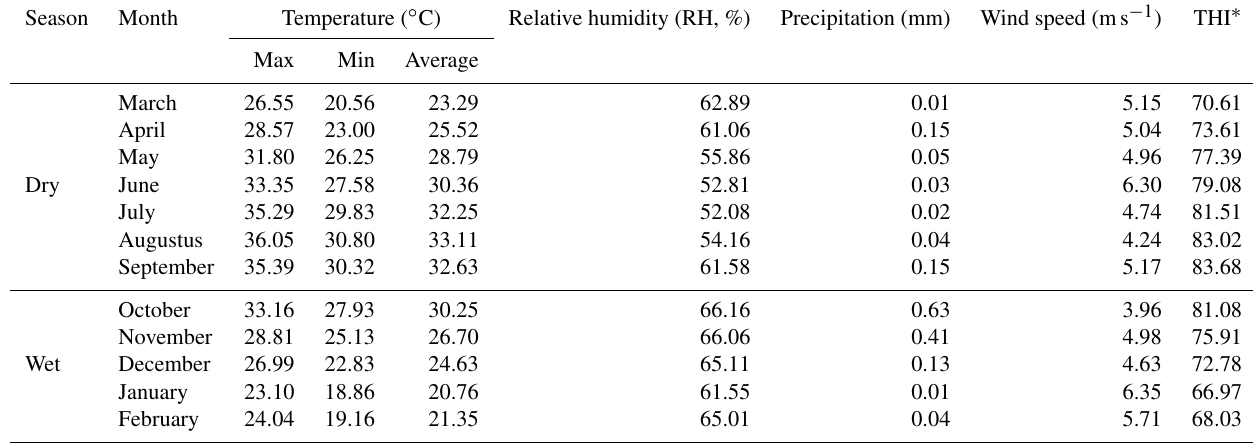
Table 1. Mean meteorological data during dry and wet seasons, provided by the Central Laboratory for Agricultural Climate, Cairo, Egypt. THI denotes the temperature humidity index, and AT refers to ambient temperature.